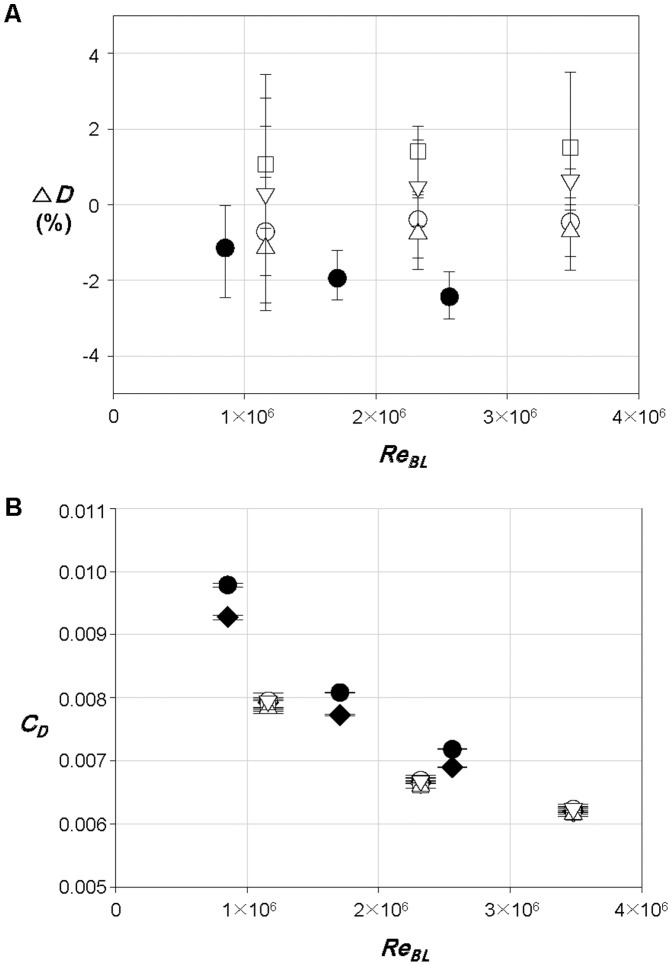
Variations of the drag and drag coefficient from those with the original bill.
A △D (%); B
CD. For the sailfish, ⋄, original bill (shown only in B); ○, short bill; □, long bill; △, smooth bill; ▽, rough bill. For the swordfish, ⋄, original bill (shown only in B); •, short bill. Here, we use the Reynolds number based on the body length, ReBL, because of the change in the bill length. Error bars are also plotted in this figure.